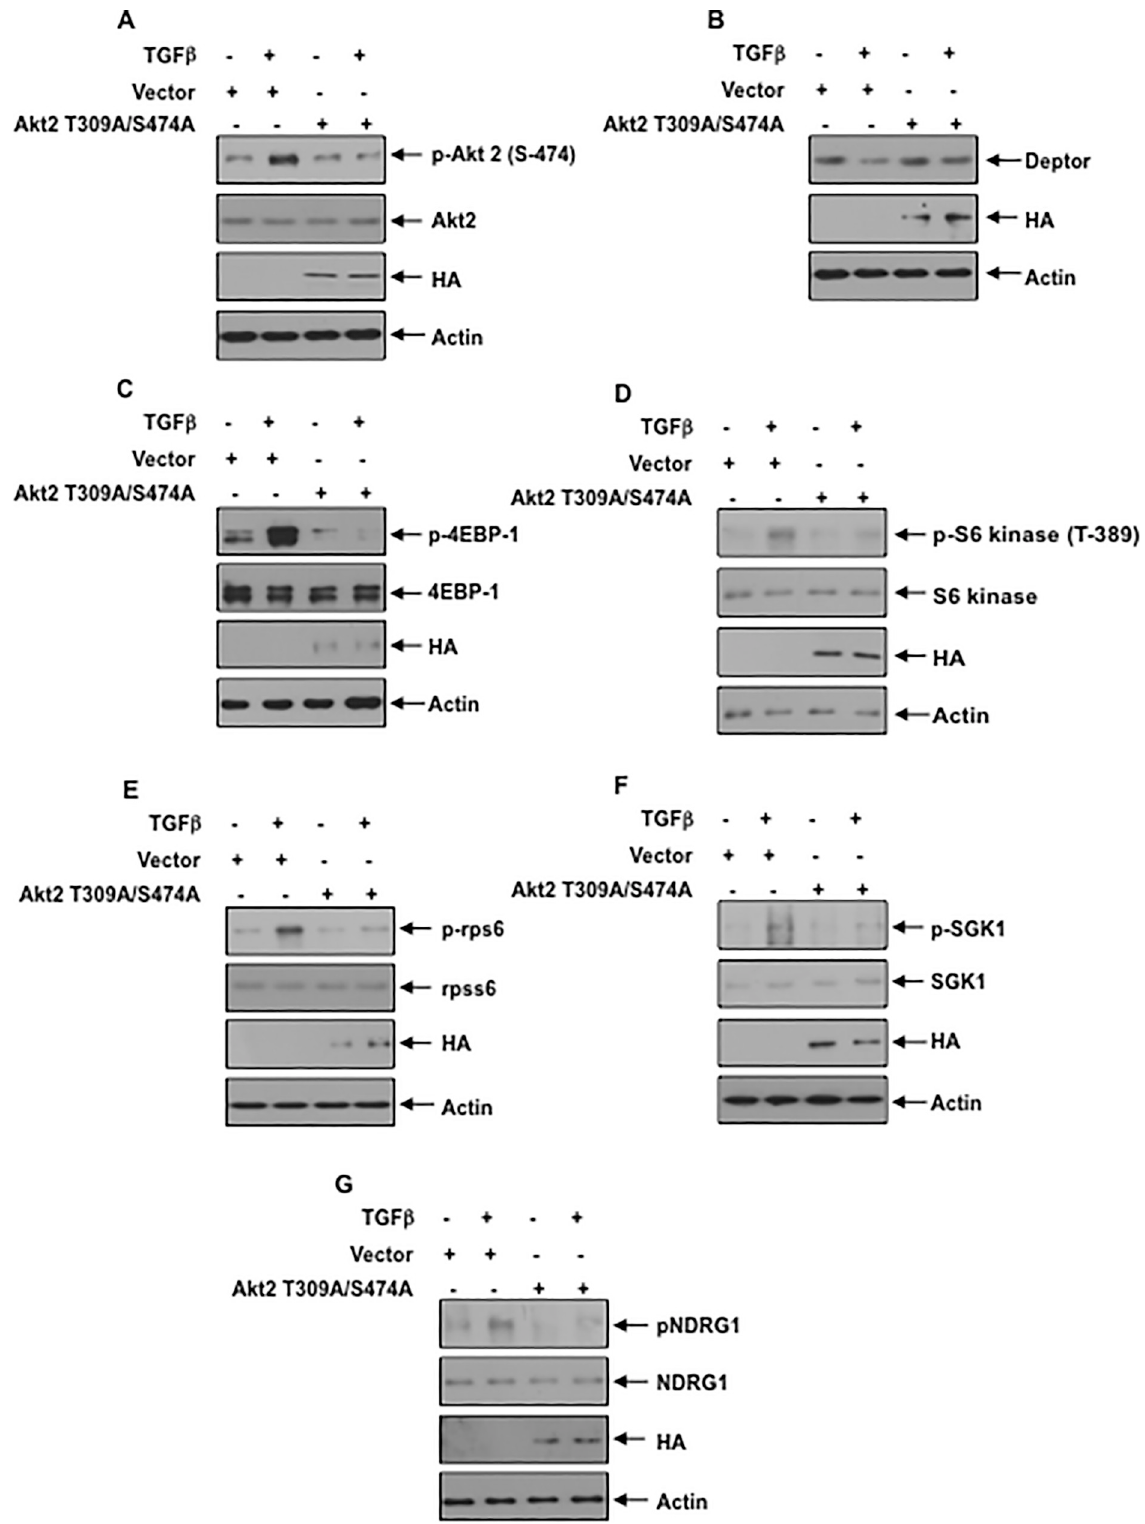
Fig 6. Phospho-deficient Akt2 T309A/S474A prevents TGF β induced decrease in deptor and activation of mTORC1 and mTORC2. (A– G) Podocytes were transfected with Akt2 T309A/S474A mutant plasmid. The transfected cells were starved and incubated with TGF β The cell